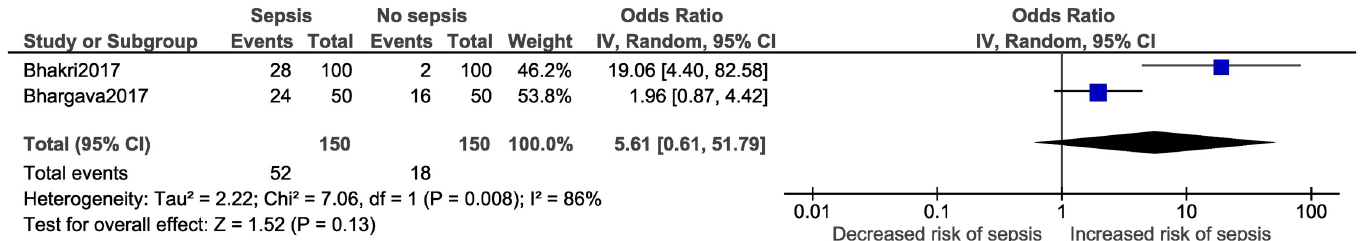
Fig 6. Forest plot showing a random-effects meta-analysis of neonates resuscitated at birth, with and without sepsis.